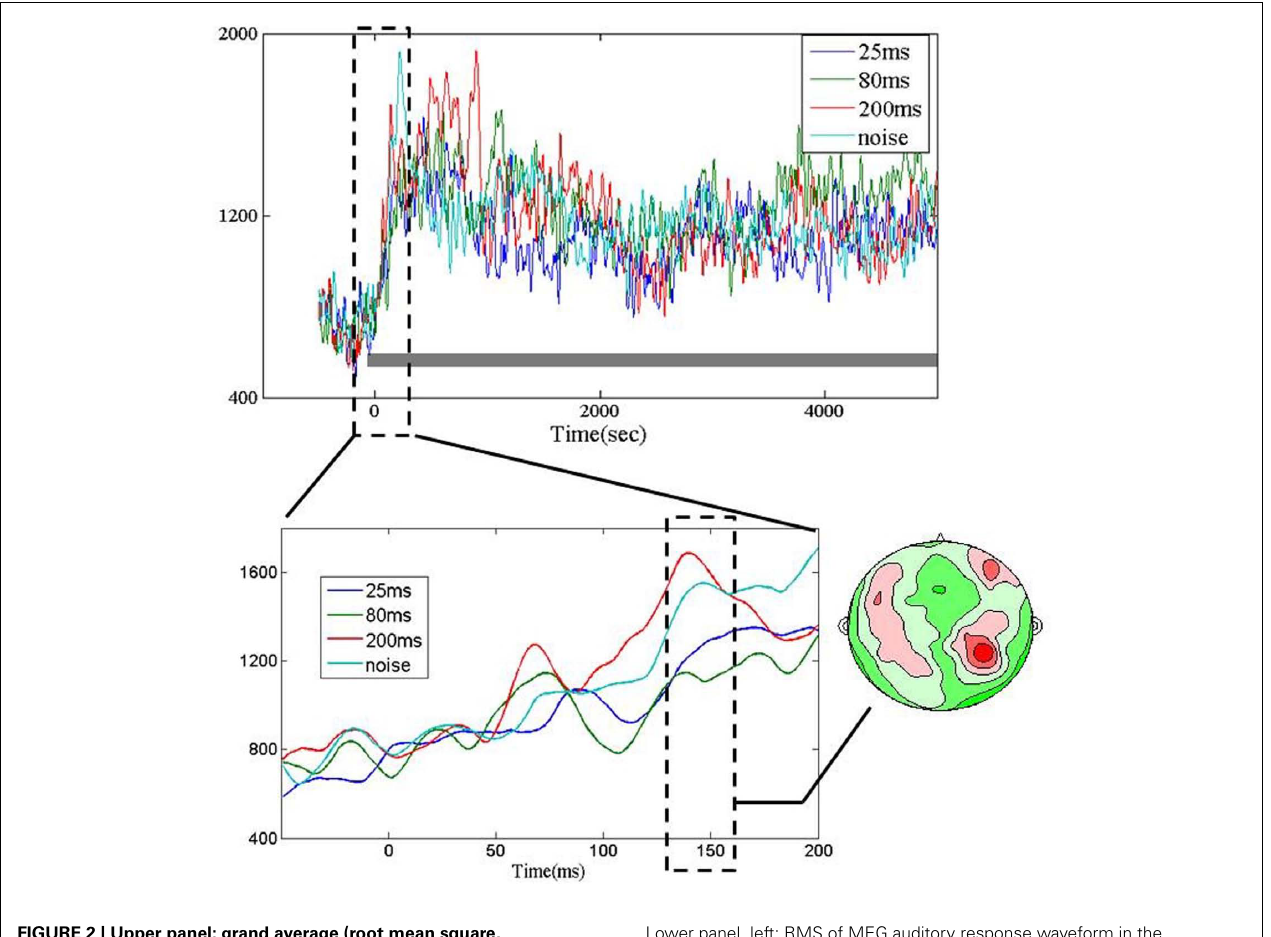
FIGURE 2 | Upper panel: grand average (root mean square, RMS) of MEG temporal waveforms in auditory channels (20 auditory channels per subject) elicited by the four types of sounds (black bar). Time 0 indicates the onset of sound stimuli.